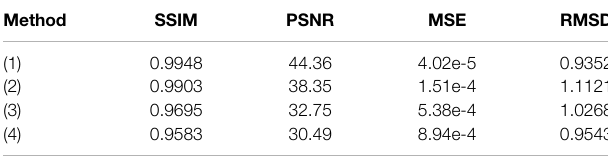
TABLE 9 | All the metric values of the recovered stress maps in Figure 10